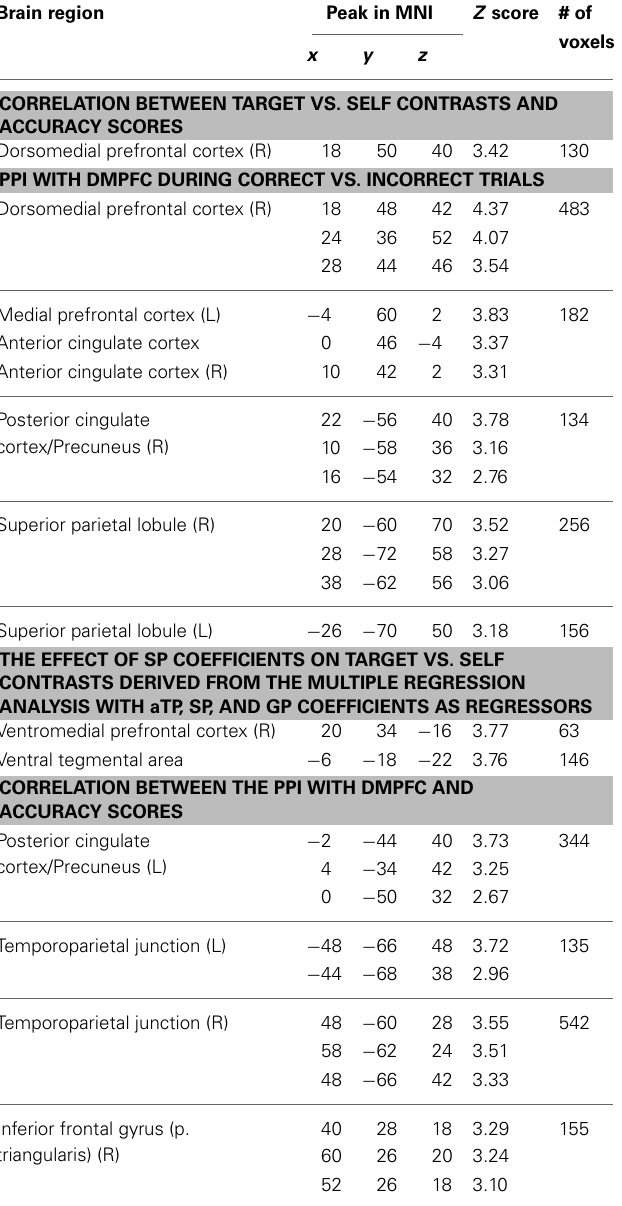
AlphaSim ( p < 0 . 05).